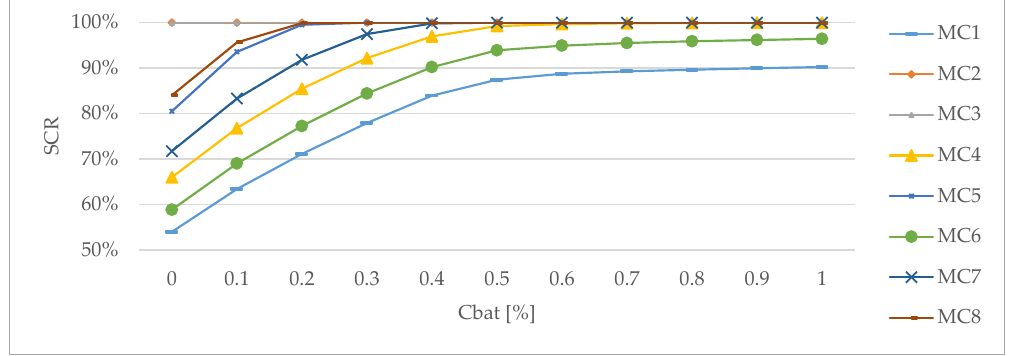
Figure 13. Comparison between the capacity of the storage system and the SCR for the MC.